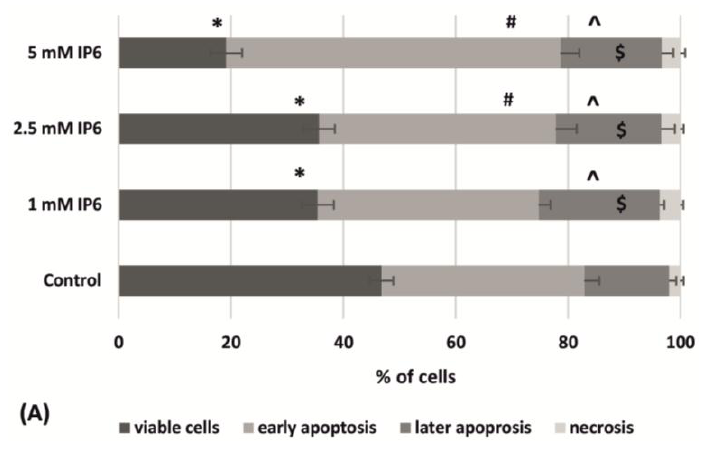
Figure 3. Figure 3 . Cont . Figure 3 . Cont .